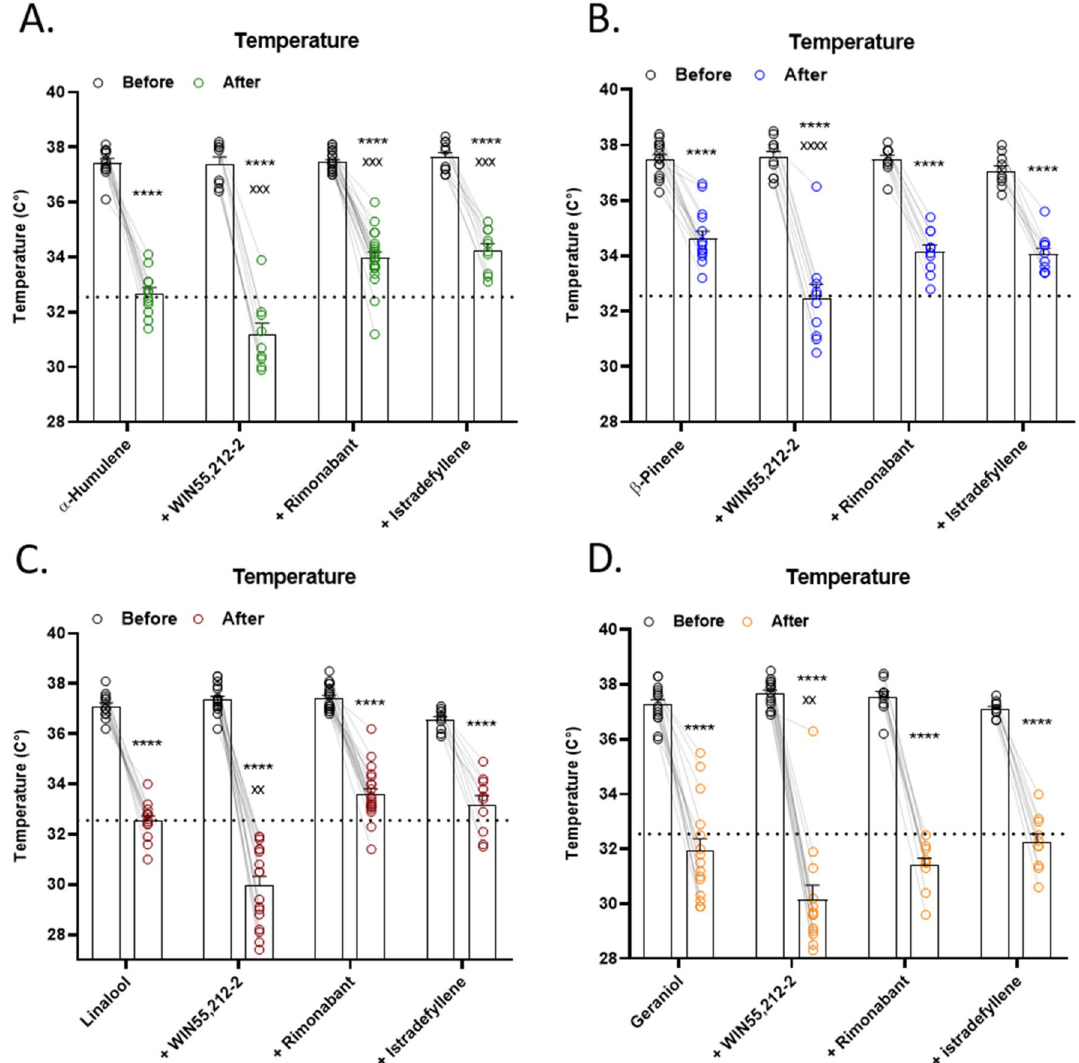
Figure 3. Terpenes Induce Hypothermia Through Mostly Non-CB1/A2a Mechanisms and are Additive with Cannabinoid. Mice were baselined for temperature, injected with 200 mg/kg terpene alone, combined with 5.6 mg/kg WIN55,212-2, or after pretreatment with 10 mg/kg rimonabant or 10 mg/kg istradefyllene. After 30 min, temperature was assessed again. ( A ) α-Humulene, ( B ) β-Pinene, ( C ) Linalool and ( D ) Geraniol. Data represents the mean ± SEM temperature (n = 10–20/group). Statistics analyzed via RM two-way ANOVA, Tukey’s post hoc; **** p < 0.0001 compared to each baseline; xx p < 0.01, xxx p < 0.001, xxxx p < 0.0001 compared to terpene post-treatment. The dashed line represents the hypothermic response to 5.6 mg/kg WIN55,212-2 alone, taken from Fig.